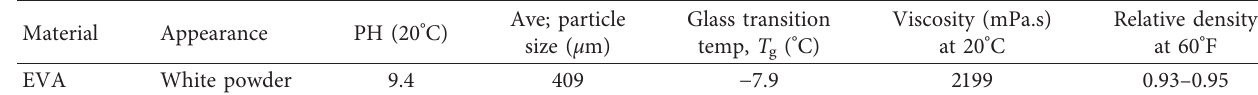
Table 3: Properties of EVA.